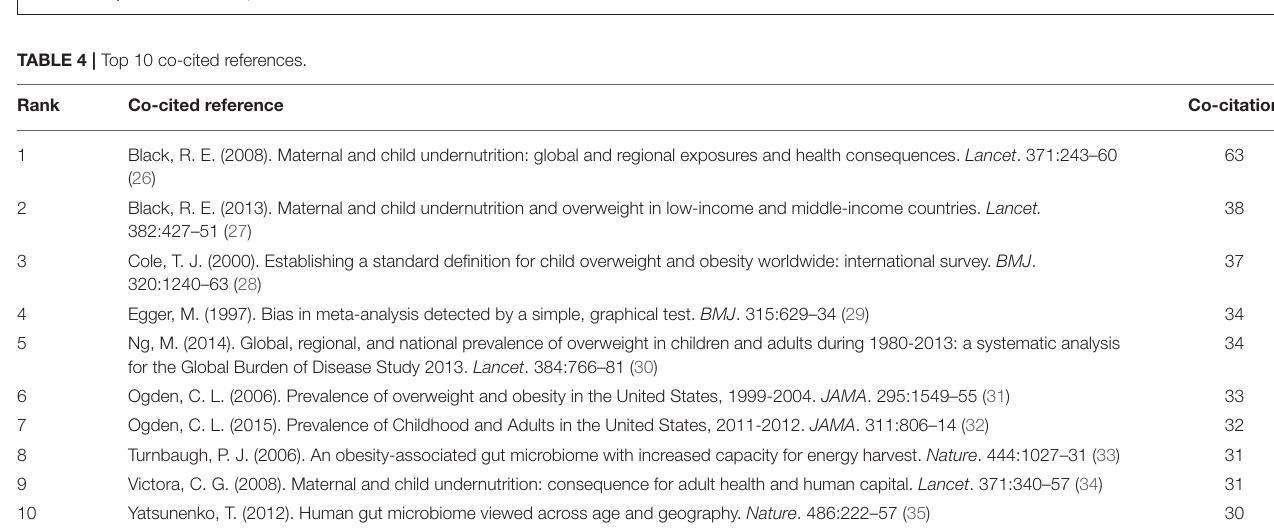
FIGURE 3 | The network map of institutions.